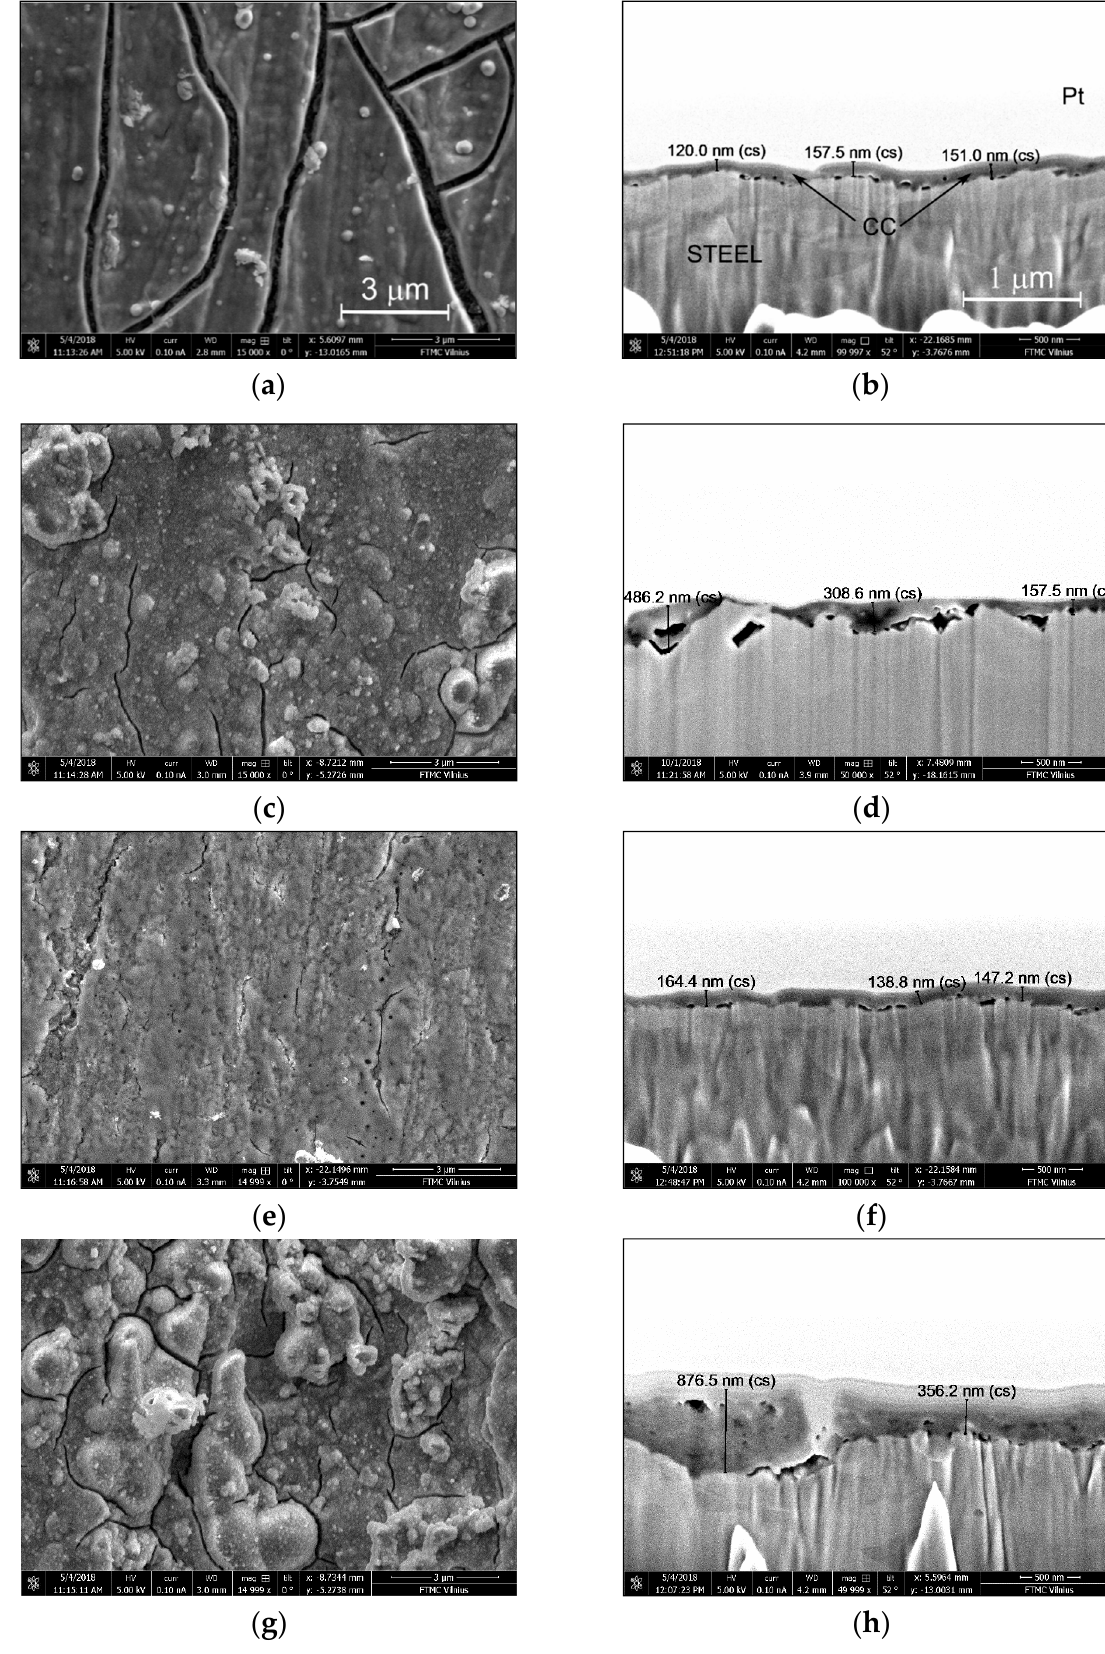
Figure 2. Top ( a , c , e , g ) and cross-sectional ( b , d , f , h ) focused ion beam scanning electron microscope (FIB-SEM) images of Fe/P-Mo ( a , b ), Fe/P-Mo-Ce1 ( c , d , g , h ) and Fe/Mo-Ce2 ( e , f ) conversion coatings. Conversion layer deposition process duration: Mo ( a – h )—20 min, Ce ( c – f )—20 min, ( g , h )—40 min. As sulphates in Ce(NO 3 ) 3 solution act as grain refiners and growth inhibitors of the Ce-containing conversion layer [12], the latter conditions are expected to affect the surface morphology and inner structure of the Ce-modified Fe/P-Mo coating. SEM images of these coatings are presented in Figure 2c–f. Indeed, a non-uniform thickness of the conversion layer, which varied between 160 and 490 nm and the presence of randomly located addi- tional crystalline aggregates, with dimensions between 0.5 and 2.5 µm, on the surface of it, were typical characteristics of the Fe/P-Mo-Ce1 coating, the top layer of which was de- posited in a pure Ce(NO 3 ) 3 solution (Figure 2c,d). Meanwhile, the presence of the sulphate ions in the Ce solution, reduced the number of structural defects such like cracks, as well as the thickness of the Ce-containing conversion layer (Figure 2e,f), which varied between 130 and 200 nm. Thus, it is obvious, that the presence of sulphates increases homogeneity and quality of Ce-modified conversion layer. Similarly to Fe/P-Mo coating formation, the